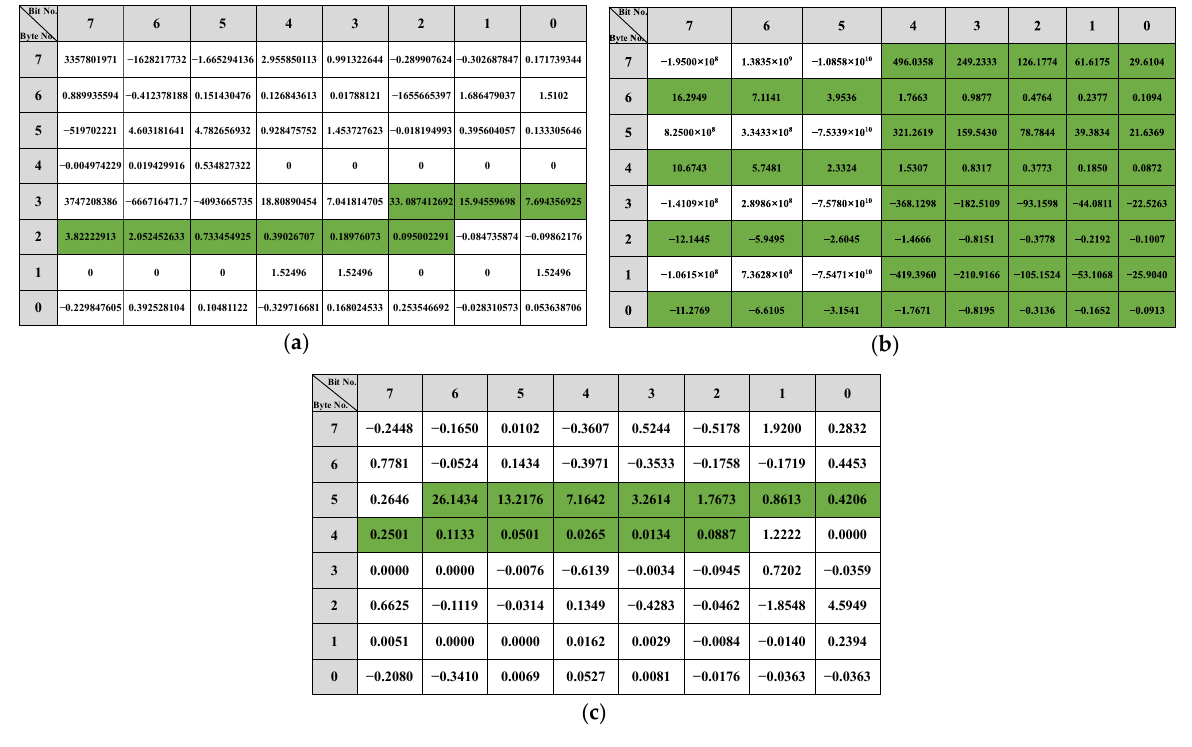
Figure 12. Speed-related messages reverse result: ( a ) ID 0x202 reverse result; ( b ) ID 0x215 reverse result; ( c ) ID 0x217 reverse result.